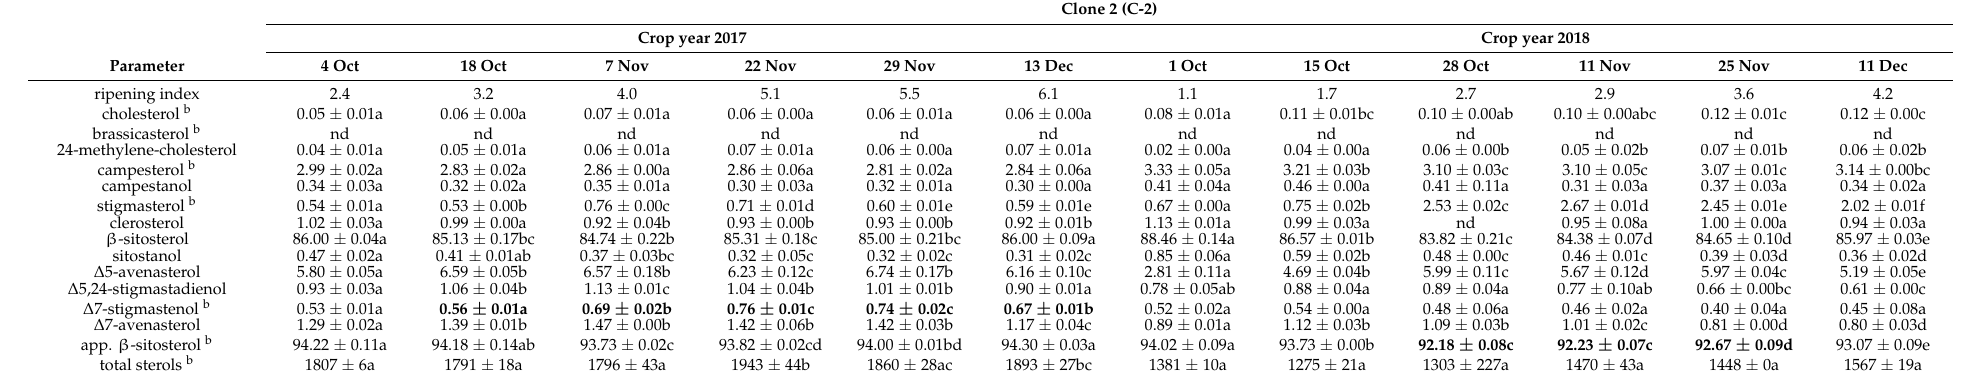
Values are mean ± standard deviation ( n = 2). a Different letters for each parameter indicate significant statistical differences ( p < 0.05) among picking dates for each crop year (a–f). b Limits established by the current regulation: total sterols ≥ 1000 mg/kg; cholesterol ≤ 0.5%; brassicasterol ≤ 0.1%; campesterol ≤ 4.0%; stigmasterol ≤ campesterol; ∆ 7-stigmastenol ≤ 0.5%; app. β -sitosterol ≥ 93.0%. Values in bold: non-compliance. Not detected =